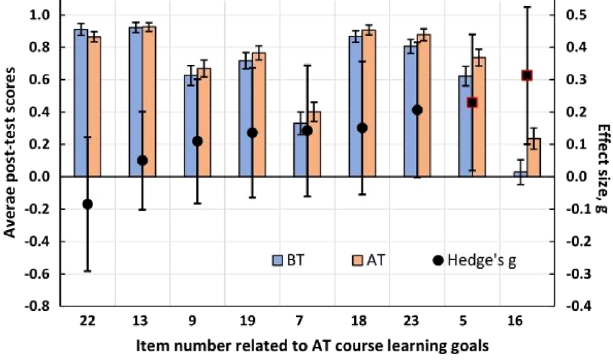
FIG. 3. Women ’ s average post-test scores in the BT (blue) and AT (orange) courses on E-CLASS items (bar graph) that are related to the AT course learning goals. Effect sizes, Hedge ’ s g and the corresponding 95% confidence intervals, are plotted as symbols for each of the items. Items with significant differences between BT and AT post-test scores for women are denoted by squares with red border.